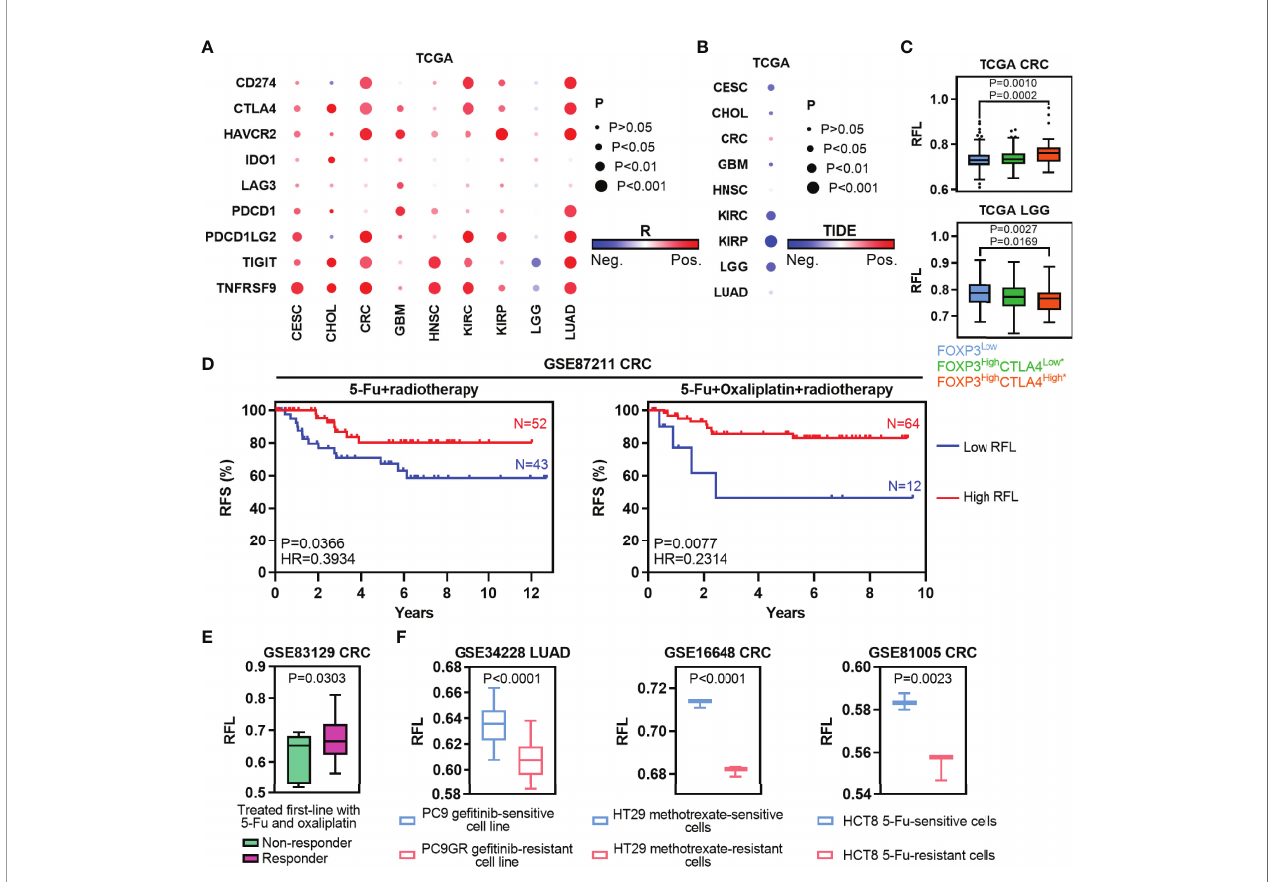
FIGURE 6 | Ferroptosis-associated molecular signature in clinically therapeutic liability. (A) Heatmaps show the correlation levels between RFL and IC expression. (B) Heatmaps show the correlation levels between RFL and TIDE values. (C) Box plots showing RFL levels grouped by each FOXP3/CTLA4 subtype in TCGA cohorts. (D) Kaplan – Meier plots show that high RFL cases were associated with a higher risk of relapse after chemotherapy/radiotherapy in the GSE87211 dataset. (E) Box plots showing the RFL level grouped by non-responder and responder after being treated fi rst-line with 5-FU and oxaliplatin in the GSE83129 dataset. (F) Barplots showing RFL levels grouped by sensitive and resistant after treated ge fi tinib, methotrexate or 5-FU in GSE34228, GSE16648, and GSE81005,